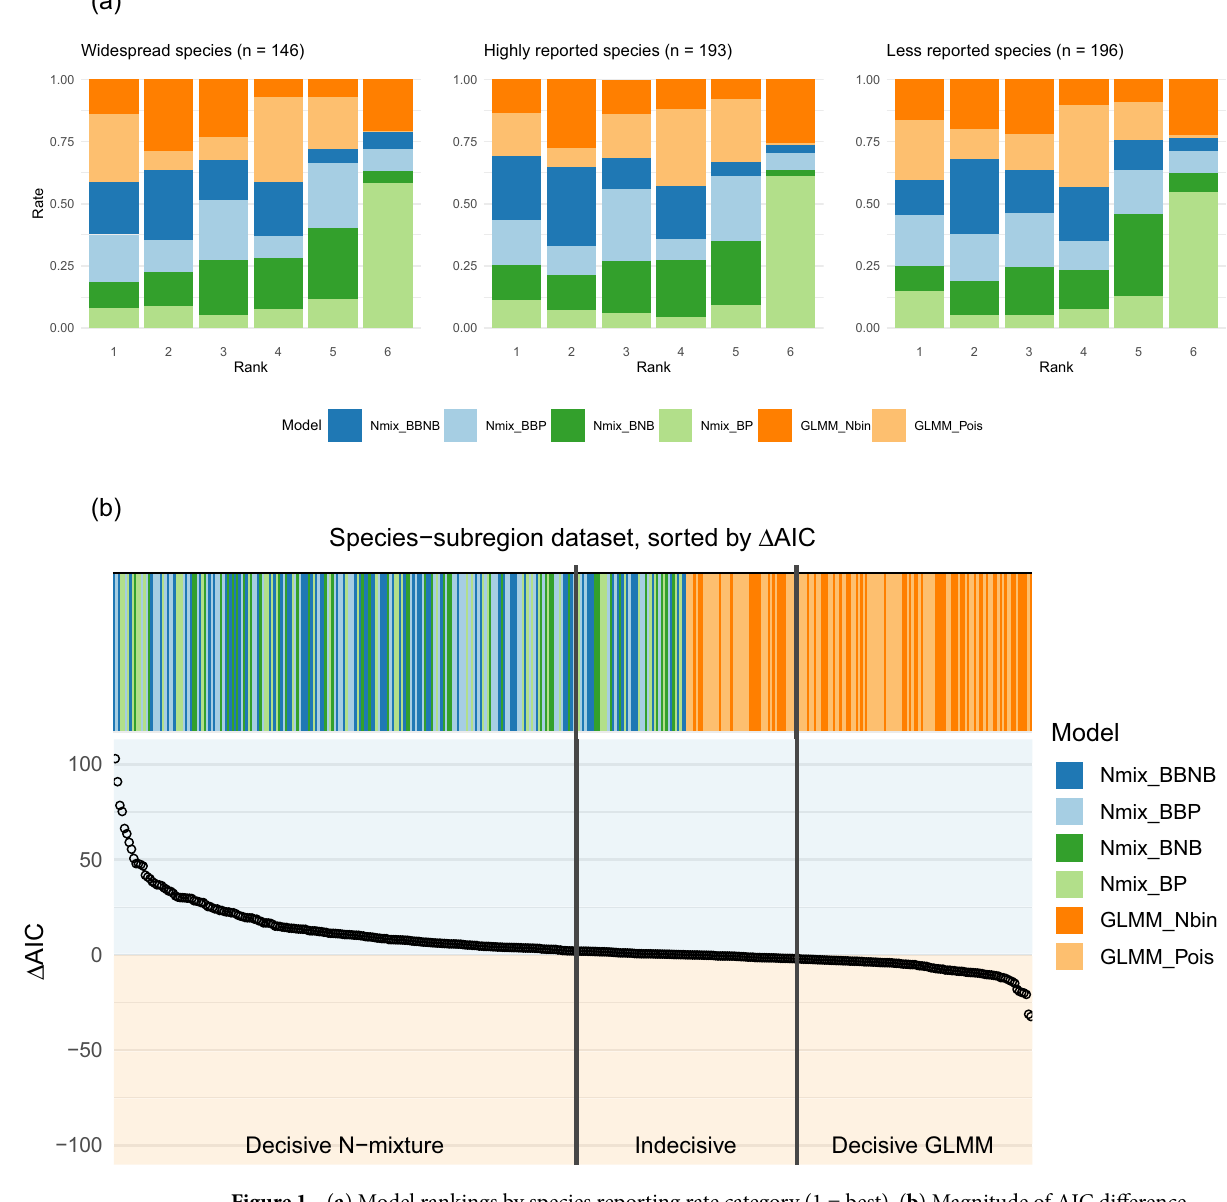
Figure 1. ( a ) Model rankings by species reporting rate category (1 = best). ( b ) Magnitude of AIC difference between the best N-mixture model and the best GLMM for each dataset. Each stripe-point pair represents one SSR dataset. Bar color indicates AIC model choice; point position on the y-axis indicates the difference in AIC ( (cid:31) AIC) between the best N-mixture model and the best